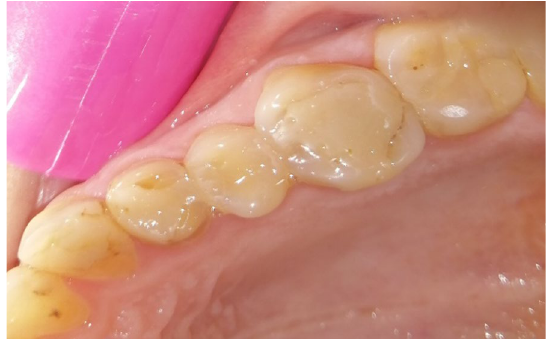
Fig. 1 Preoperative view of the tooth to be